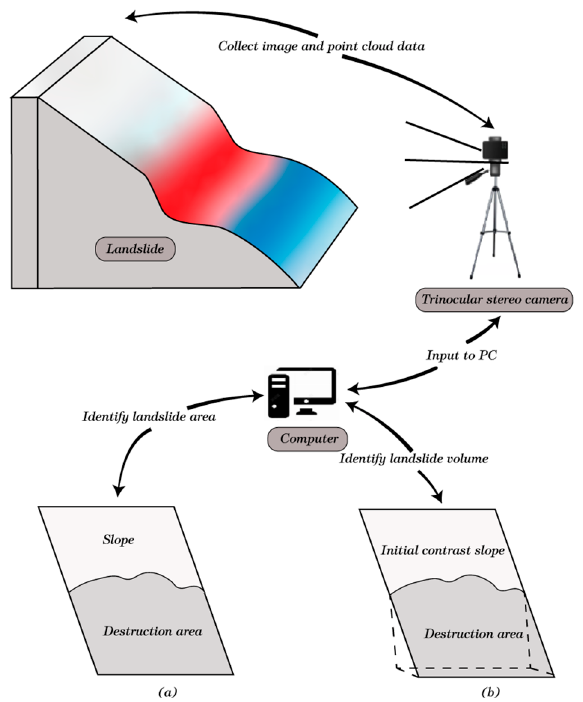
Figure 3. Schematic diagram of quantitative identification of deformation areas. ( a ) Schematic diagram of landslide area calculation. ( b ) Schematic diagram of landslide volume calculation.